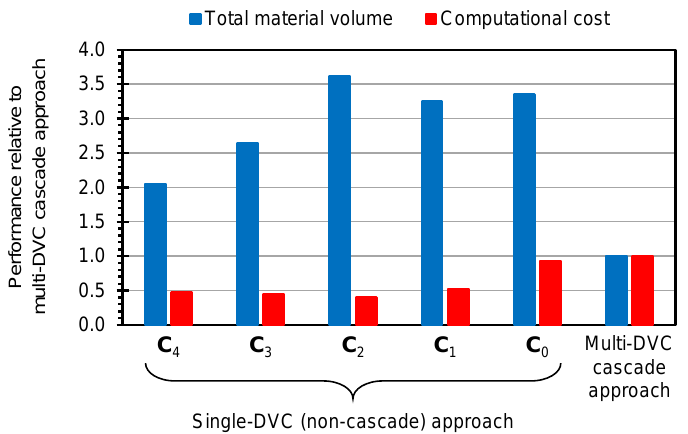
Figure 8. Test Problem 1 (wing box): finally attained material quantity and corresponding computa- tional cost for various optimization runs. The results are given as ratios, relative to the performance of the multi-DVC cascade optimization approach.